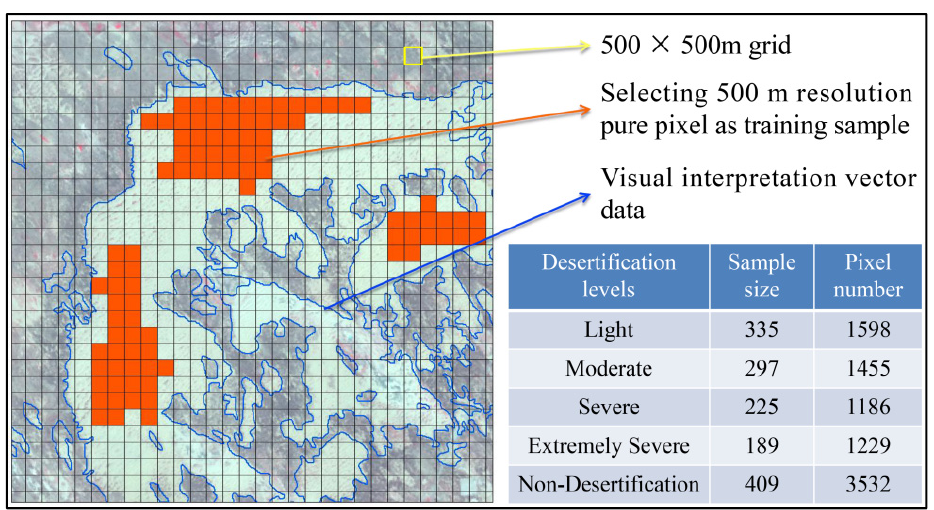
Figure 2. The sample selection and sample size in the study.